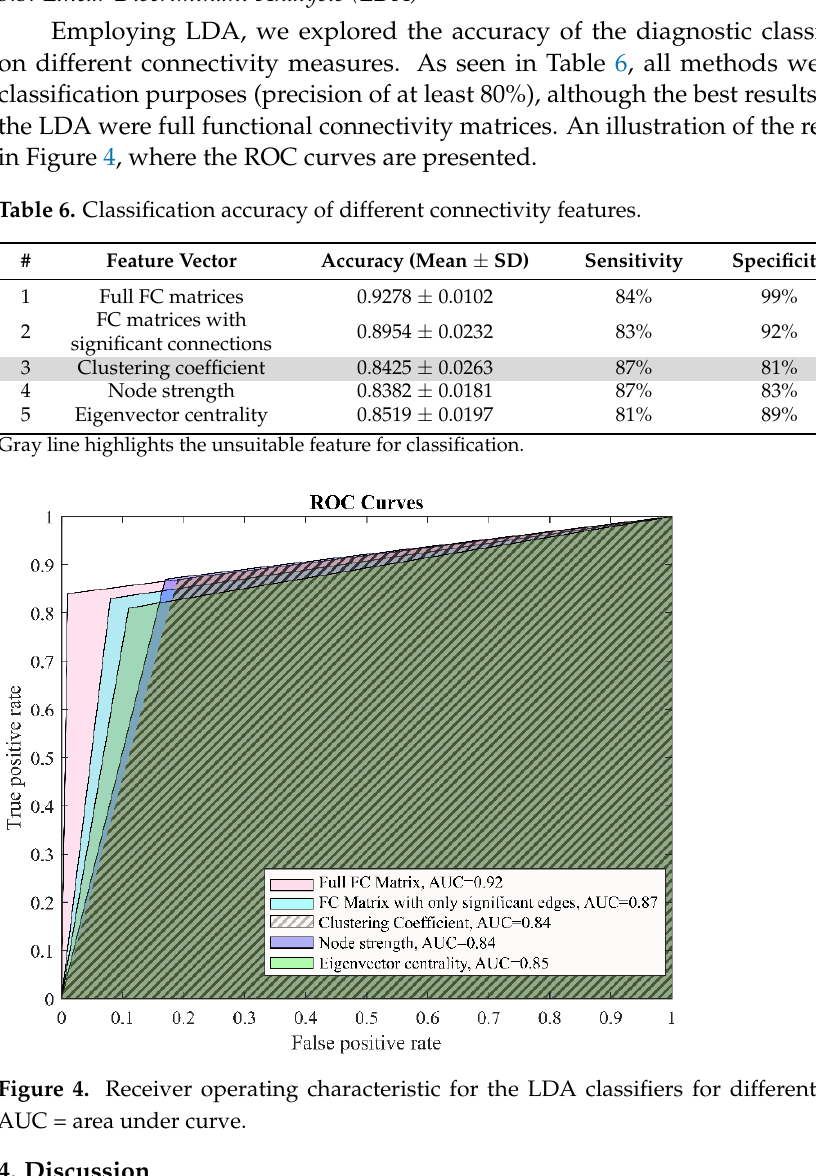
Table 6. Classification accuracy of different connectivity features.